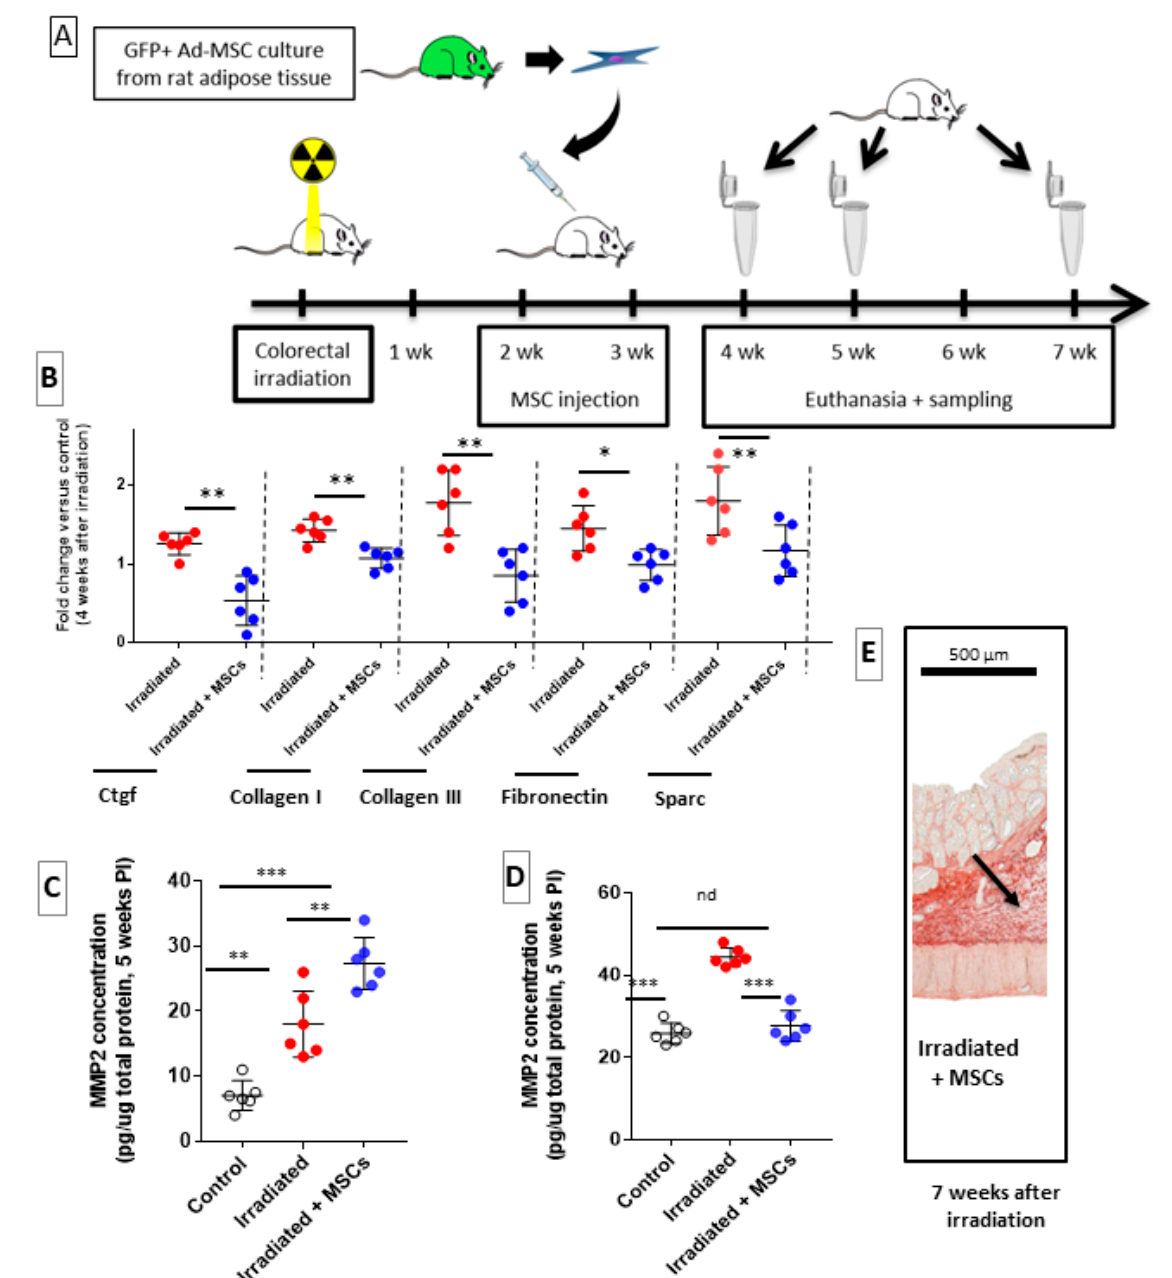
Figure 2. Effect of MSC transplantation on radiation-induced ECM remodeling. ( A ) Timeline of irradiation and MSC transplantation protocol. ( B ) mRNA fold changes of genes 4 weeks after irradiation (red dots) and 1 week after MSC injection (blue dots) that are normalized to Ywhaz and standardized against Control group. mRNA fold changes of genes encoding CTGF and ECM components indicate suppression of pro-fibrotic signals by MSCs. ( C ) Five weeks after irradiation: MSCs increase secretion of MMP-2 in the irradiated colon–rectum area. ( D ) Percentage of fibrosis area quantified on Picrosirius Red-stained slides. MSCs significantly inhibit ECM deposition in the colon–rectum area of irradiated animals as observed 7 weeks after irradiation. ( E ) Representative images showing ECM (black arrow) stained with Picrosirius red (original magnification: 40×) in the colon–rectum area of irradiated + MSCs group, 7 weeks after irradiation (original magnification: 40×). Each group of animals was composed of 6 rats. The results of each group were compared as follows: Irradiated group was compared to Control group; Irradiated + MSCs group was compared to control and Irradiated group. Two-group comparisons were performed with t -tests, while one-way ANOVAs, followed by Bonferroni t -tests, were used for multiple group comparisons. The results are expressed as mean ± SD. *: p < 0.05; **: p < 0.01; ***: p ≤ 0.001.